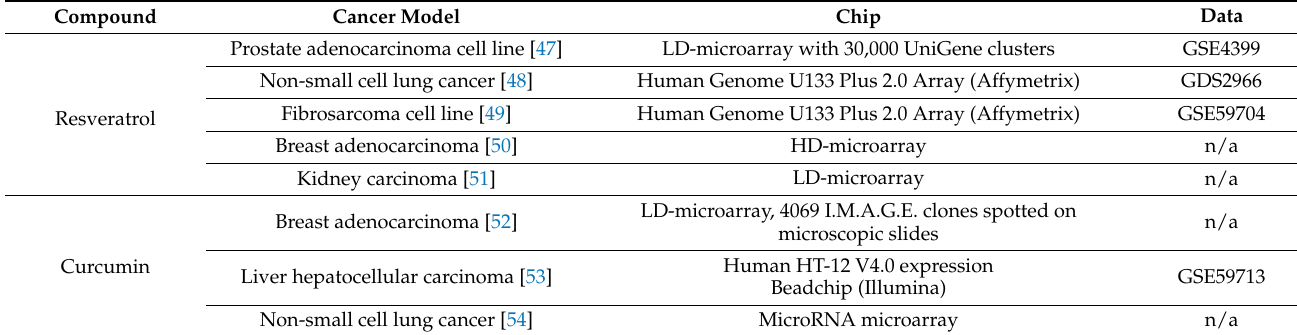
Table 5. Functional genomic studies of resveratrol and curcumin.